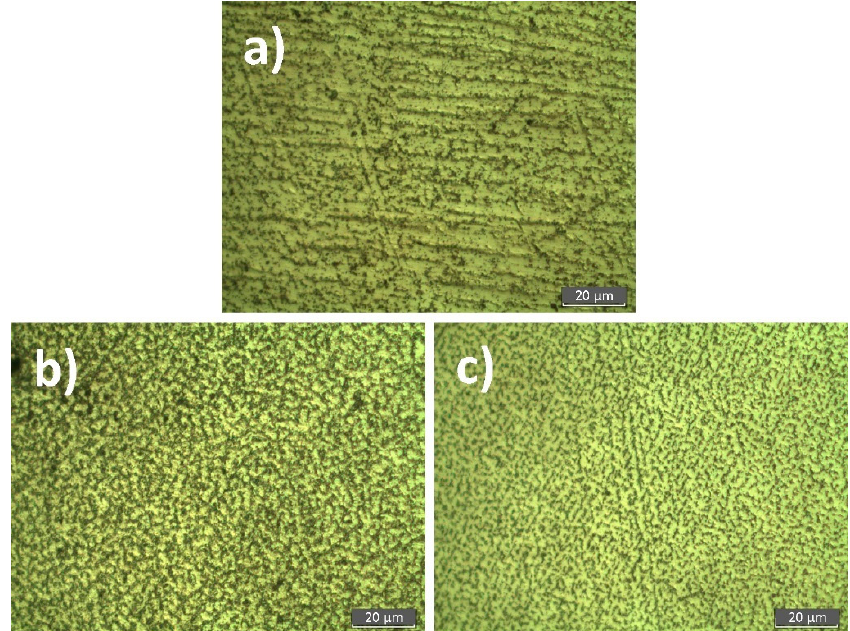
Figure 6. Microstructure of sintered Co pellets (700 °C) for sets ( a ) I, ( b ) II, ( c ) III of Co powders as determined through optical